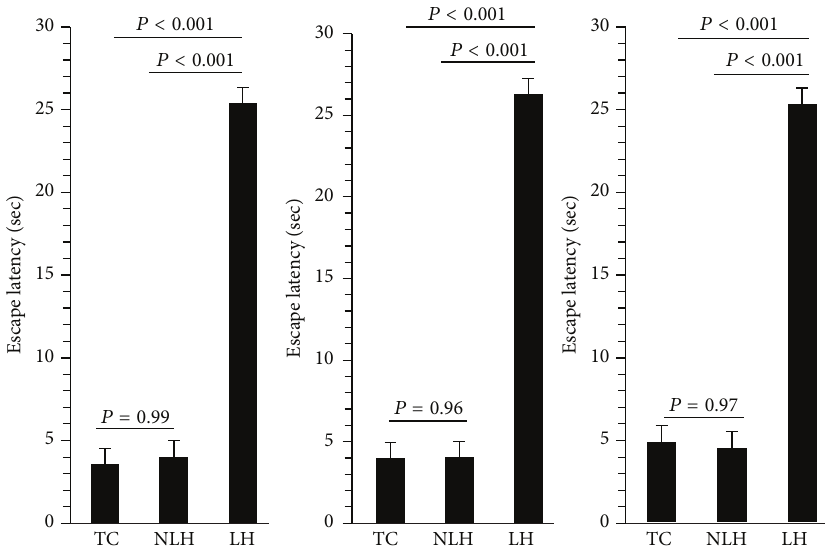
Figure 1: Escape latencies in LH, non-LH, and TC rats measured on days 2, 8, and 14. Data are the mean ± SD from 6 rats in each group. Overall group differences were as follows: day 2: 𝐹 = 2,15 , df = 179, and 𝑃 < 0.001 ; day 8: 𝐹 = 2, 15 , df = 134, and 𝑃 < 0.001 ; and day 14: 𝐹 = 2, 15 , df = 132, and 𝑃 < 0.001 . Individual group analysis revealed that, at all these time intervals, LH group was significantly different from NLH or TC groups ( 𝑃 < 0.001 ). There was no significant difference between NLH and TC groups.